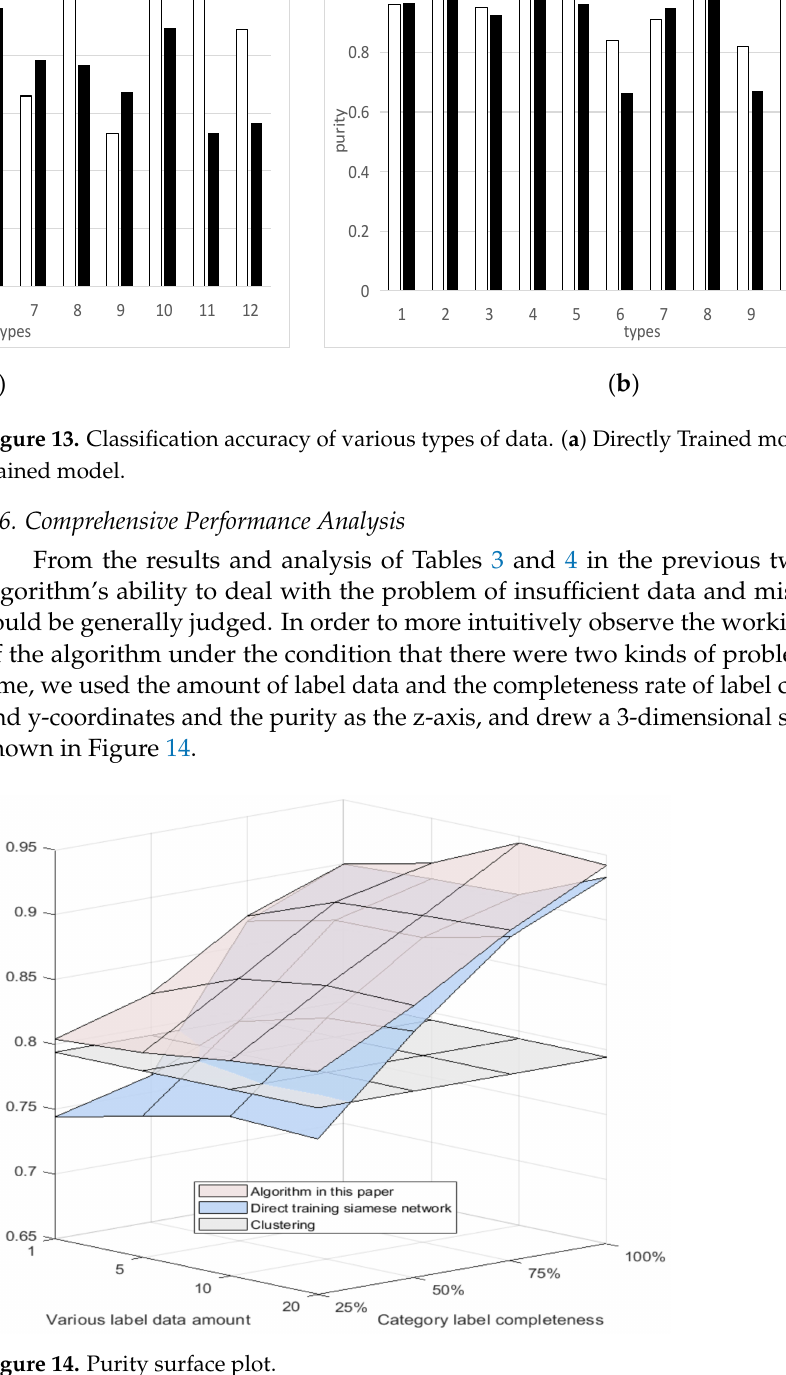
Figure 14. Purity surface